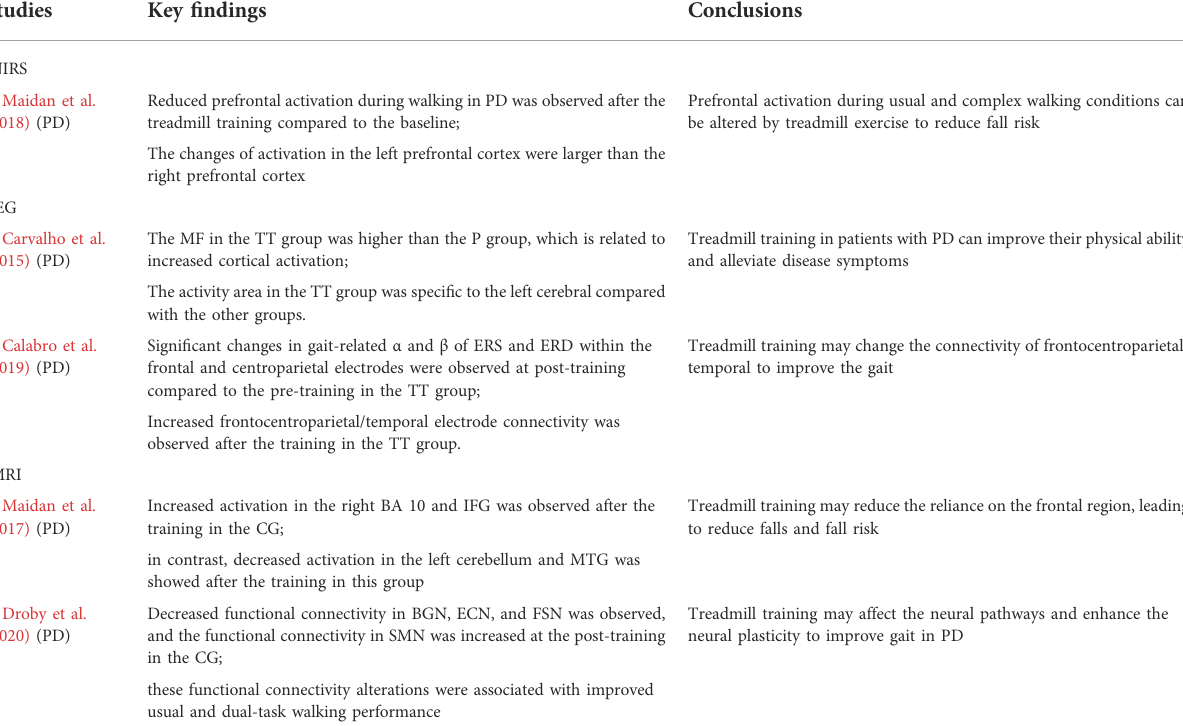
TABLE 6 Key fi ndings and conclusions of the studies in people with